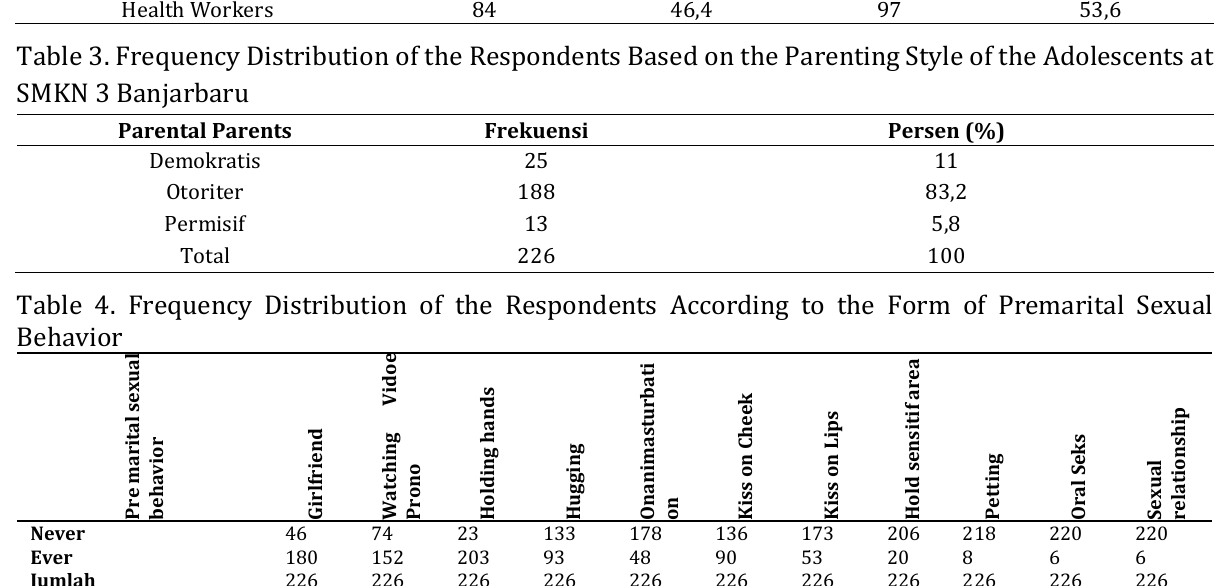
Table 5: Relationship Test Results between Parenting Style and Adolescent Premarital Sex Behavior Variable Parenting